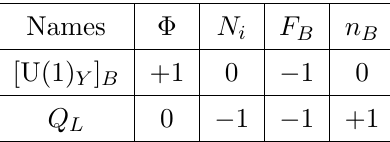
Table 1 . Additional twin fields shown for model described in section 3.2. (Related SM fields not shown.)